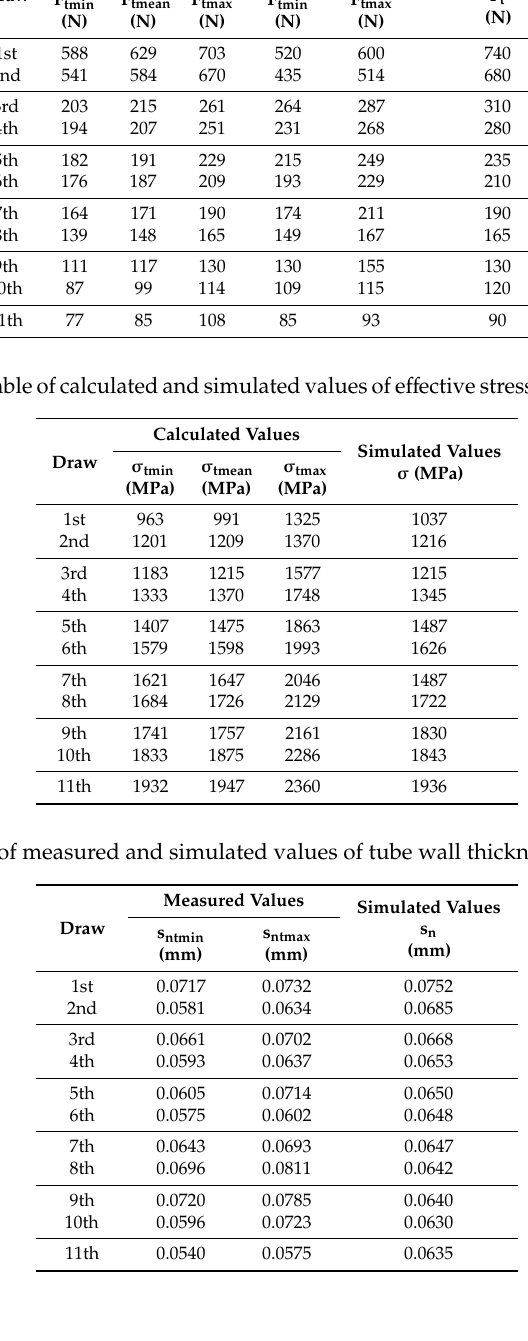
Table 5. Comparison table of the calculated, measured and simulated values of drawing forces. Calculated Values Measured Values Draw